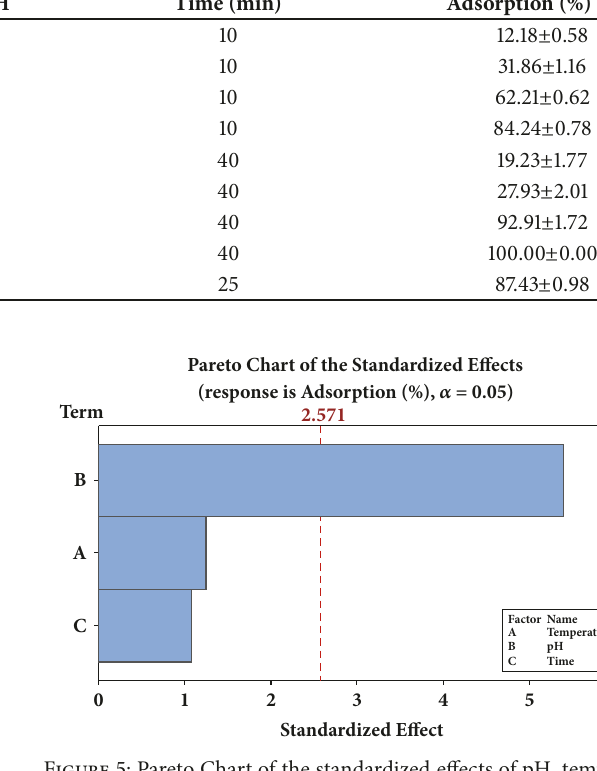
9, respectively. To investigate the main effect of all factors, the adsorption efficiency was studied using the Pareto chart and the result is shown in Figure 5. The most affecting factor is the pH followed by temperature and then agitation time. The Pareto chart provides a clear visualization of the factor effects and indicates that the pH has the most significant effect on the adsorption at 𝛼 = 0.05; however, the temperature and agitation time did not show values lower than the reference line (2.571 at 𝛼 = 0.05) [2, 25]. From this analysis, the adsorption (%) can be calculated or predicted according to the following model (1)